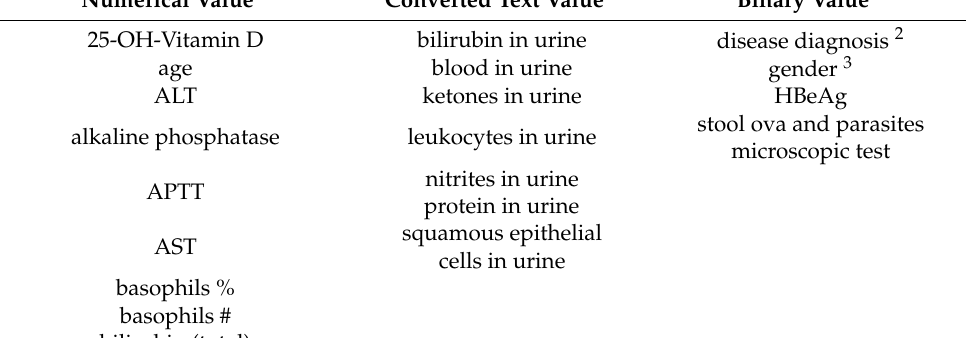
Table 3. Filtered input features in alphabetical order used for the machine learning